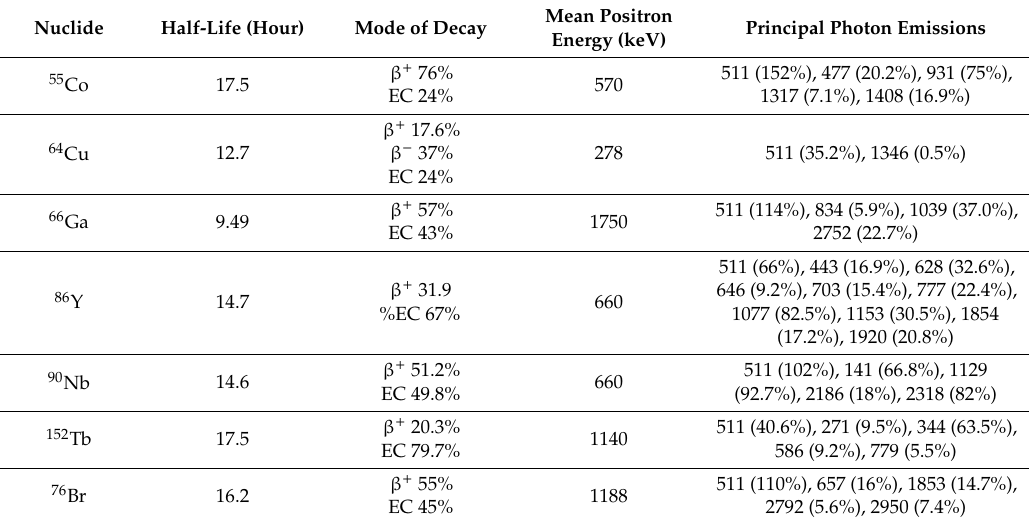
Table 5. Positron-emitting nuclides with potential for imaging at 24 h after injection (https: // www.nndc. bnl.gov / nudat2 /